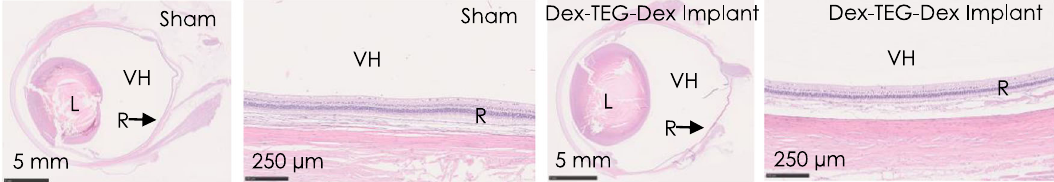
Fig. 10 Ocular histopathology following intravitreal implantation of a dexamethasone dimer implant in the rabbit eye. Histology (hematoxylin and eosin (H&E)) of a rabbit eye 12-months post-intravitreal sham procedure or administration of Dex-TEG-Dex implants. VH – vitreous humor, L – lens, R –